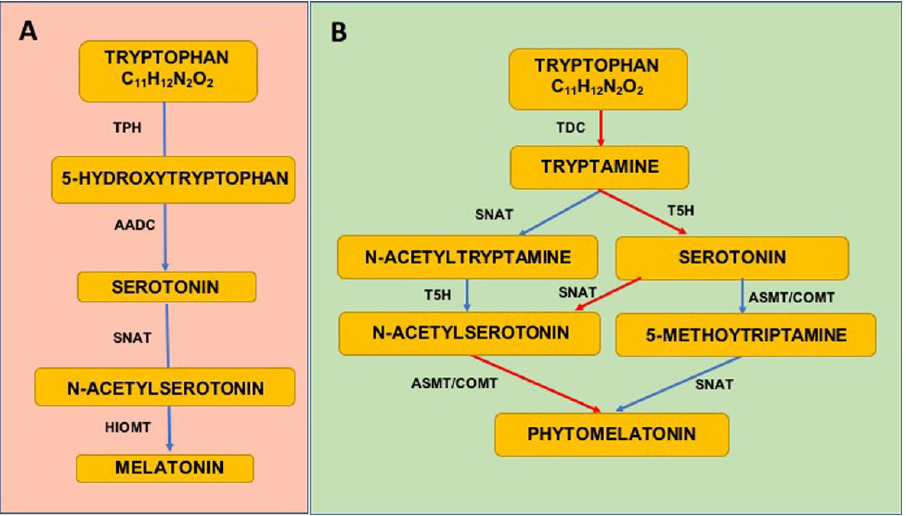
Figure 1. Biosynthetic pathways of melatonin in animals ( A ) and in plants ( B ). Red arrows indicate the most relevant way of phytomelatonin synthesis.